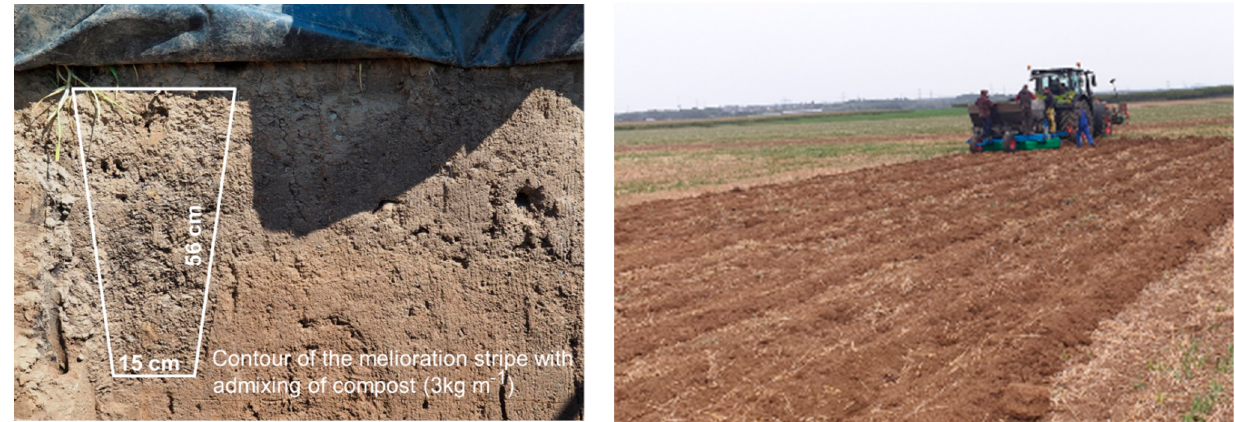
Figure 10. Melioration stripes with mixed compost ( left ) and field surface after melioration ( right